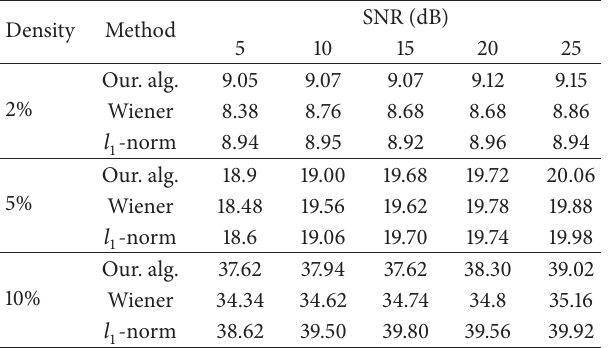
Table 3: Real scatters detection according to their density. Density